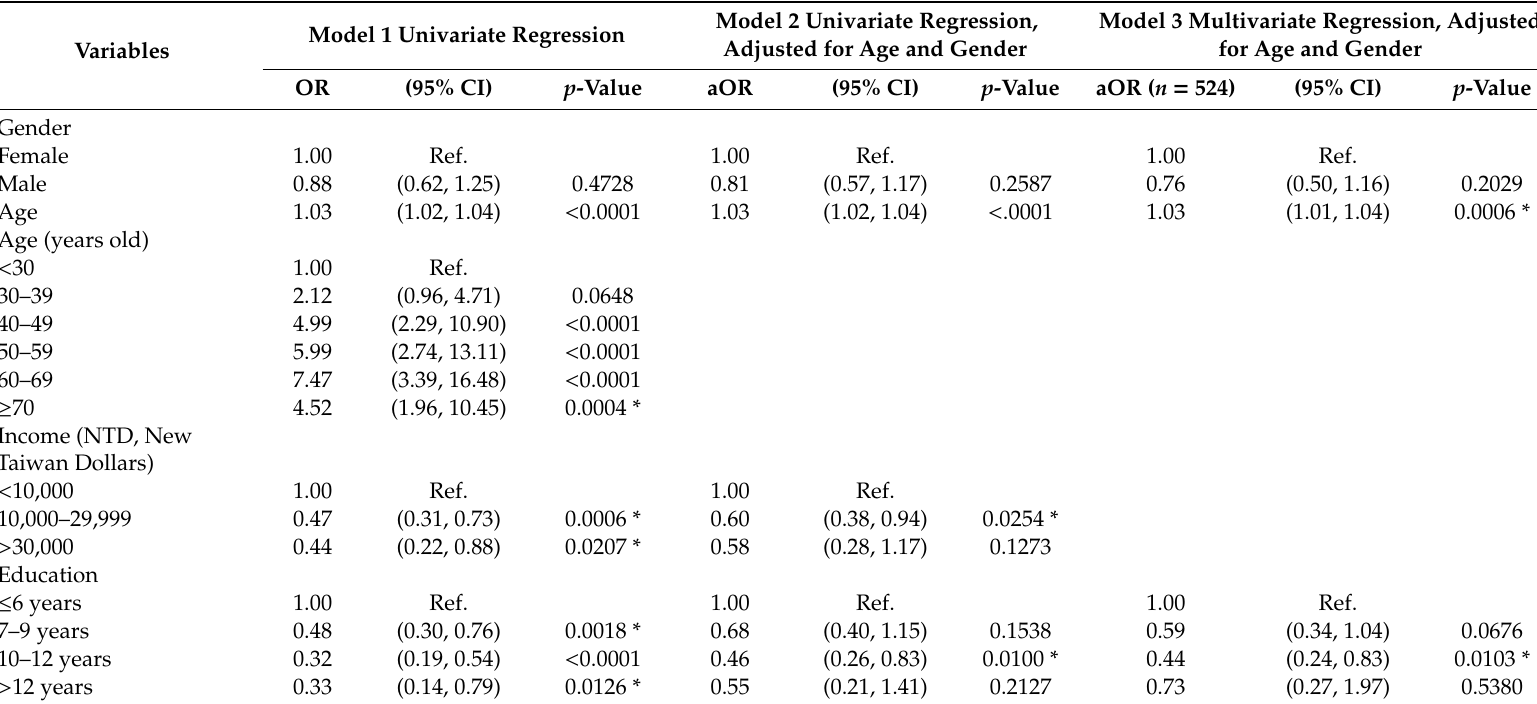
Table 3. Results of univariate and multivariate regression models on possible variants comparing those with and without metabolic